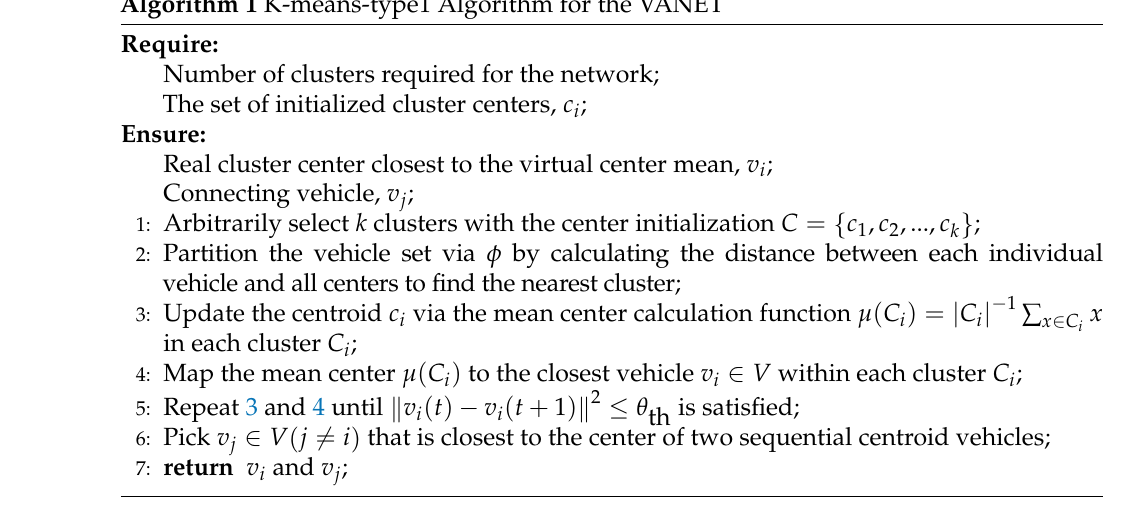
Algorithm 1 K-means-type1 Algorithm for the VANET